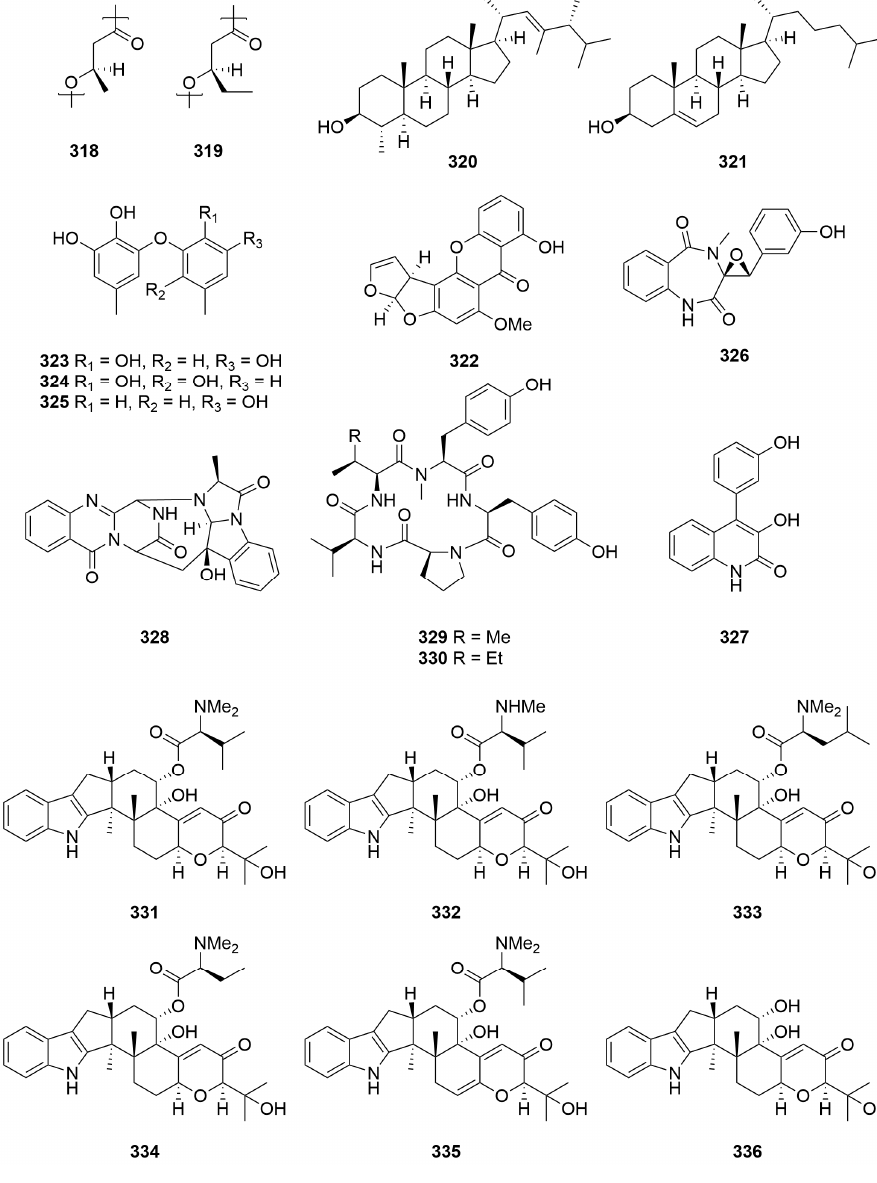
Figure 20. Compounds 318 to 336